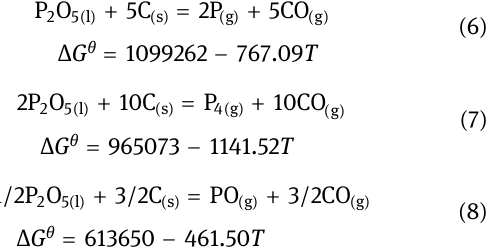
O that contain 2 5